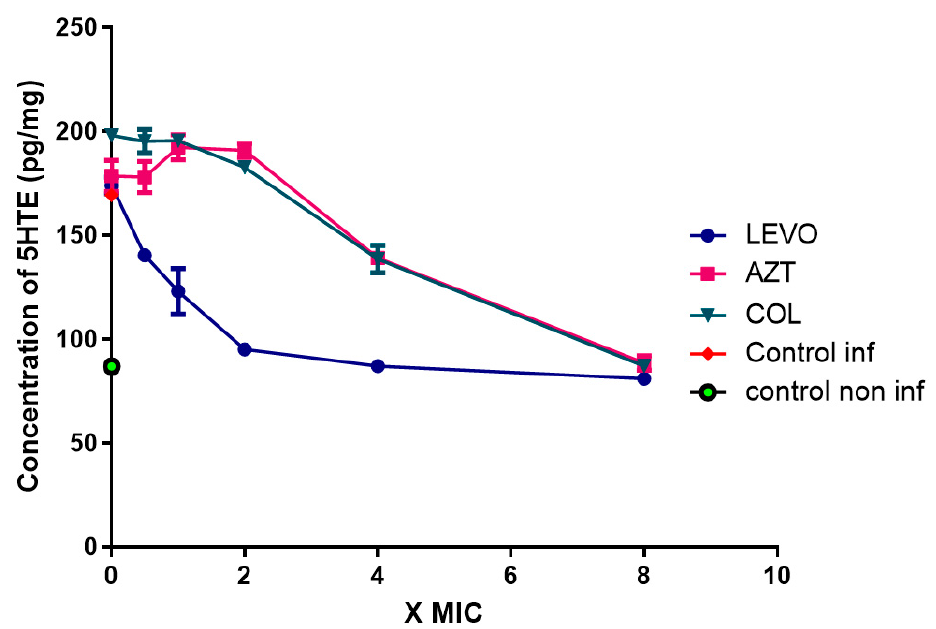
Figure 4. Concentration of 15-HETE (pg/mg of protein) in extracts of human lung epithelial NCI-H292 cells infected or noninfected with P. aeruginosa , 24 h post-infection. (LEVO = levofloxacin, AZT = aztreonam, COL = colistin, Control inf = control in infected cells, Control non inf = control in noninfected cells).